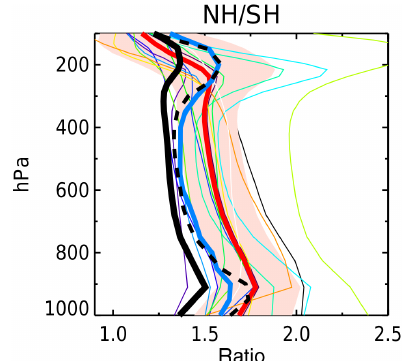
Figure 7. Vertical profile of inter-hemispheric gradient of annual mean ozone concentrations estimated from the reanalysis (black lines), ACCMIP ensemble mean (red solid line), ACCMIP models (thin colored lines), and ozonesonde observations (blue solid line). The reanalysis result is shown for the average over all model grid points (black solid line) and over the ozonesonde samplings (black dashed line). The ± 1 σ deviation among the ACCMIP models is shown in